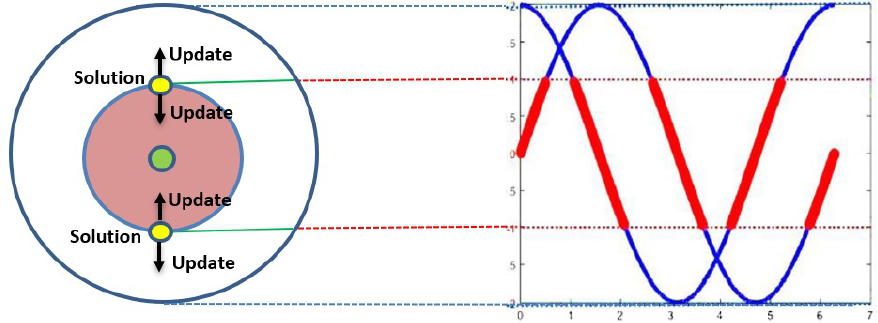
Figure 8. Solution update process toward or moving away from the best